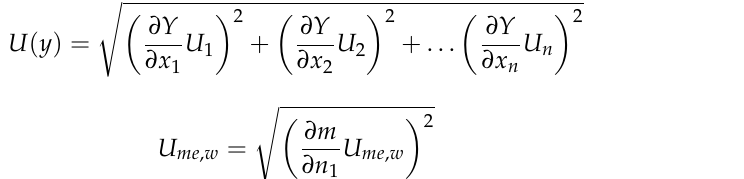
Figure 5. Experimental setup.